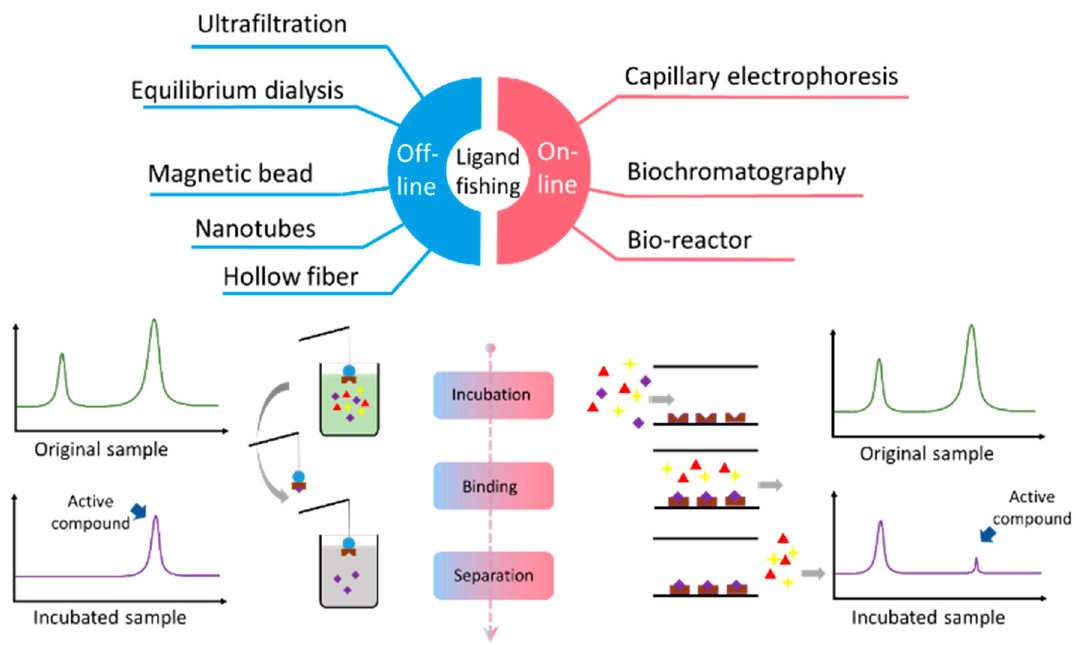
Figure 1. Scheme of ligand fishing applied to screening active compounds from complex mixtures. The left part shows the off-line mode: the affinity selection step usually performed independently, and the binding complexes were removed to eluent to obtain the active compounds, then using LC or MS to analyze them. The right part shows the on-line mode: the target molecules were immobilized inside of the chromatographic system, and the analysis and separation were simultaneous. The signal of active compounds would be lower than the original sample because of the affinity binding.